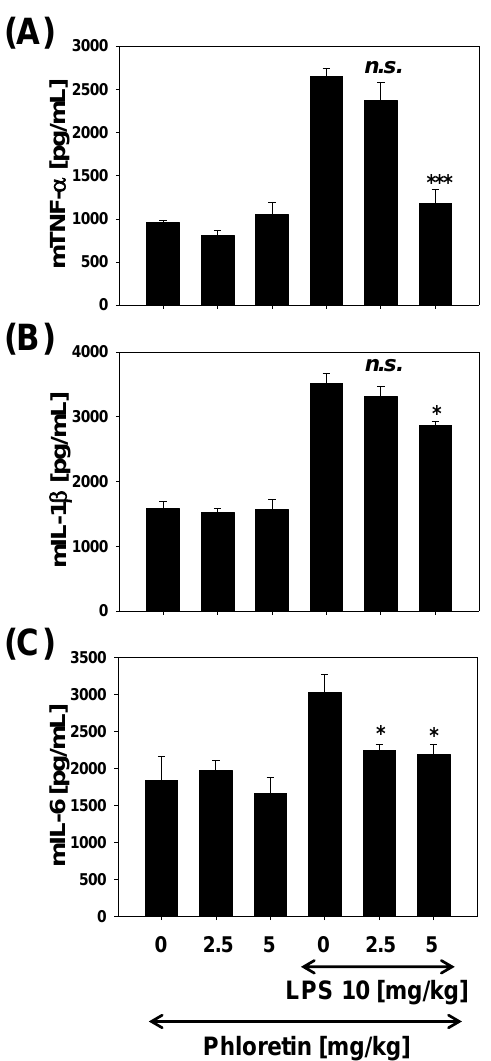
Figure 6. Inhibition of the pro-inflammatory cytokines ( A ) tumor necrosis factor (TNF)- α ; ( B ) interleukin (IL)-1 β ; and ( C ) IL-6, in a mouse model of lipopolysaccharide (LPS)-stimulated lung inflammation. * p < 0.05, *** p < 0.001 vs. cells treated with LPS only.